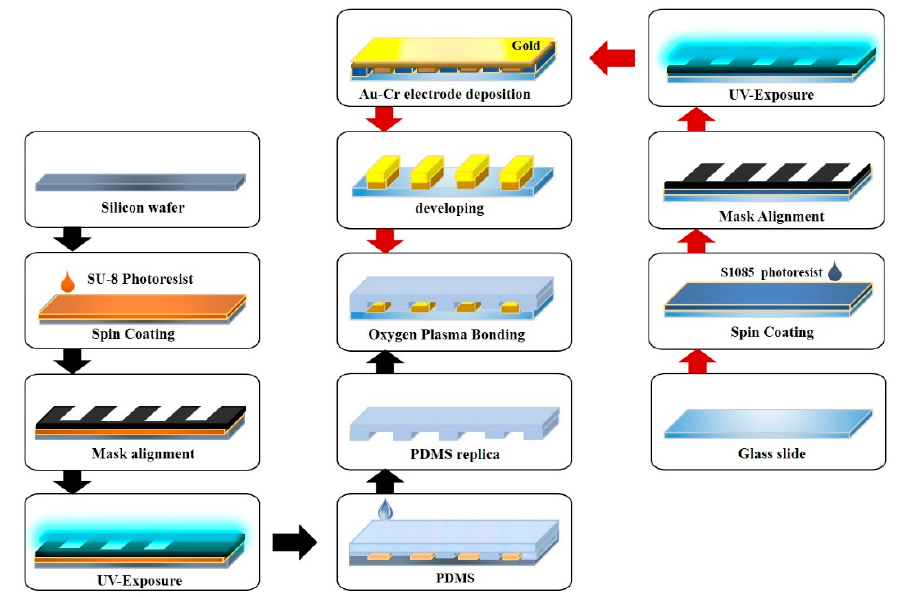
Figure 6. Schematic representation of the electrochemical microfluidic chip (EMC) fabrication processes.